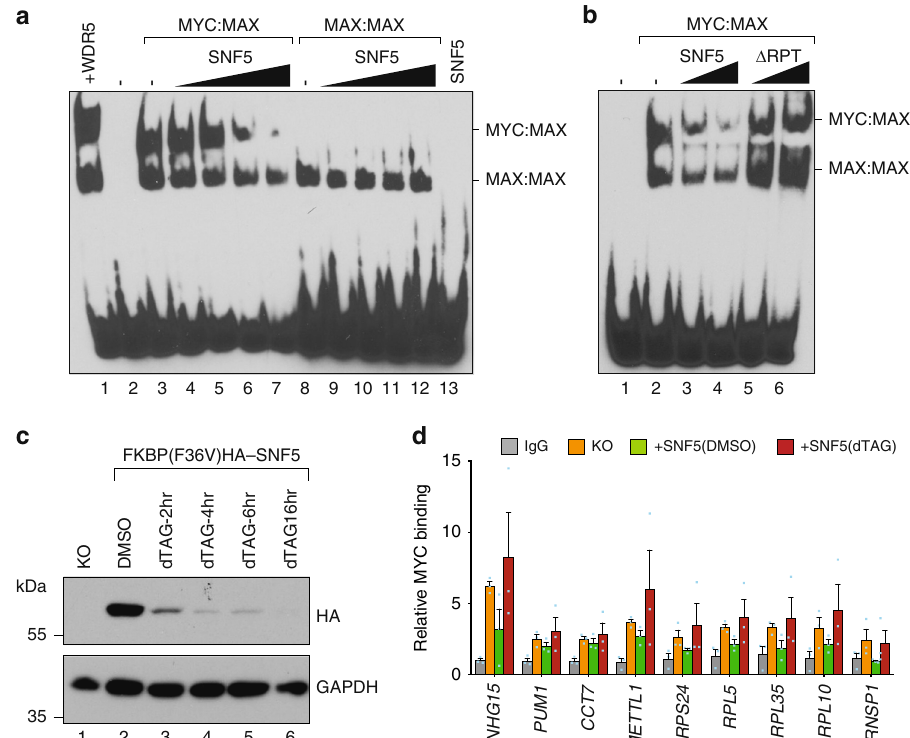
Fig. 1 SNF5 inhibits DNA-binding by MYC. a Recombinant MYC:MAX or MAX:MAX complexes were incubated with increasing amounts of recombinant SNF5 (3-, 6-, 12-, 24-fold molar excess over MYC:MAX) and EMSA performed using a DNA probe carrying a wild-type E-box sequence. Note that MYC: MAX complexes also contain residual MAX:MAX dimers. Lane 1 shows that incubation with the MYC interactor WDR5 (12-fold molar excess) induces a supershift in the MYC:MAX complexes. Lane 13 is the top concentration of SNF5, without MYC or MAX proteins. b EMSA, as in a , except MYC:MAX complexes were incubated with either recombinant SNF5 (12-, 24-fold molar excess) or an SNF5 mutant lacking the imperfect repeats region (amino acids 176 – 309) that interact with MYC ( Δ RPT; 12-, 24-fold molar excess). Results were con fi rmed with two independent preparations of recombinant proteins. c SMARCB1 -null (KO) HEK293 cells were transduced to express FKBP12 (F36V) − HA-SNF5, treated with DMSO or 500 nM of dTAG-47 for the indicated times, lysates prepared, and the levels of HA-tagged degradable SNF5 determined by immunoblotting. Lysate from the KO cells is included as a control in lane 1. GAPDH is a loading control. d SMARCB1 -null (KO) HEK293 cells were transduced to express FKBP12 (F36V) − HA-SNF5 ( + SNF5) and treated with DMSO or dTAG-47 (500 nM) for 2 h. ChIP assays were then performed. IgG control is shown for the dTAG-47-treated sample. Anti-MYC ChIPs are shown for the KO and the treated + SNF5 cells. Relative MYC binding is calculated as the signal at each of the indicated loci, relative to a non-MYC-bound locus ( β -globin). n = 3 independent ChIP experiments. Error bars are standard